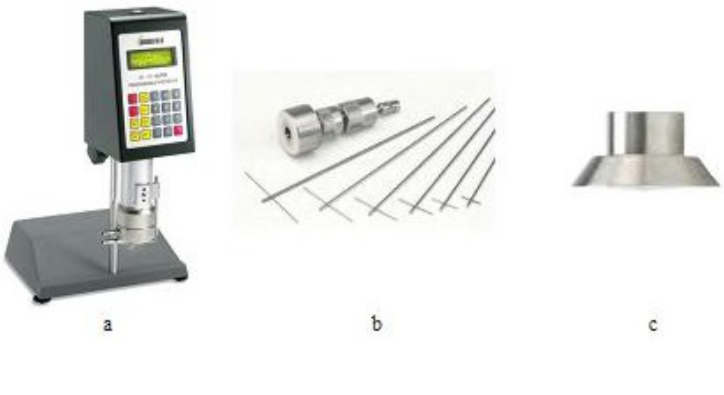
Figure 2. The Brookfield HADV-III Ultra viscometer, a–device, b–set of Helipath spindles, c–spindle of the CPE-52 cone